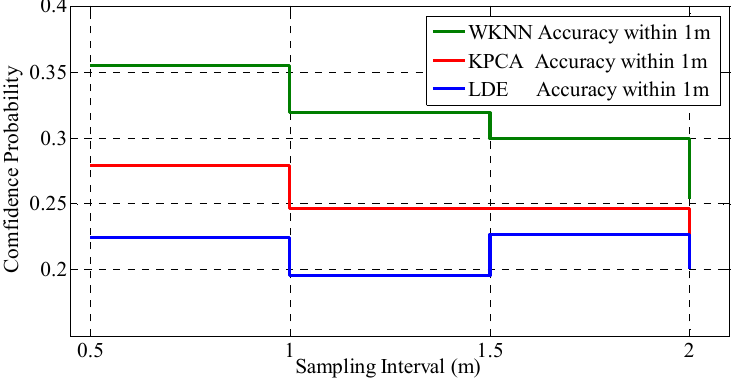
Figure 16. Performances of different positioning systems with different sampling density under the condition that the positioning error distance is within 2